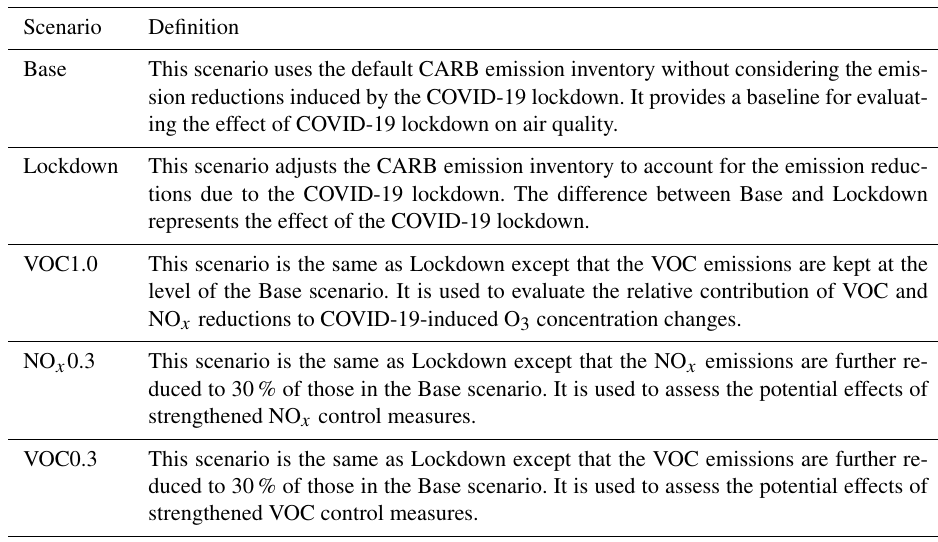
Table 1. Summary of model scenarios developed in this study.